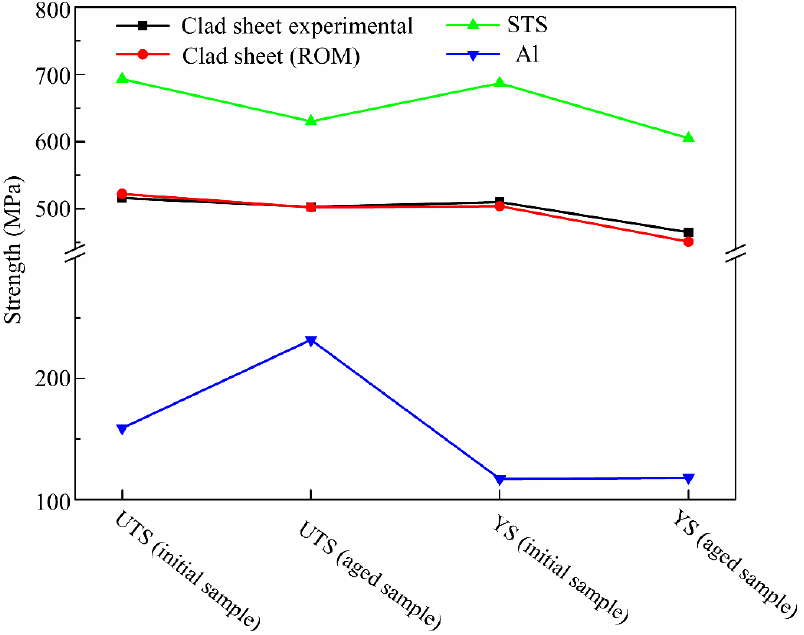
Figure 9. UTS and YS values of initial and aged Al/steel composites, and the individual Al and steel layers.